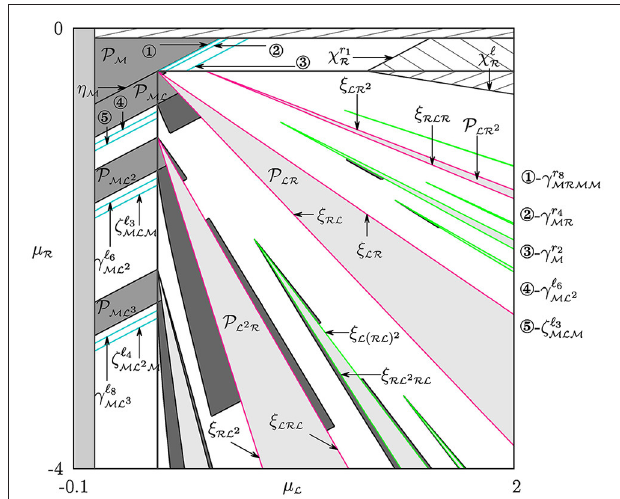
FIGURE 4 | Bifurcation structure of the ( µ L , µ R )-parameter plane of map f : periodicity regions of the STM structure, as well as the PA and the fin structures are shown moderate gray, light-gray, and dark-gray, respectively. For chaoticity regions of the STM structure their boundaries are shown with blue lines. For PA regions of the first complexity level their boundaries are plotted red, while green color corresponds to the second complexity level. The parameters are as in Figure 2